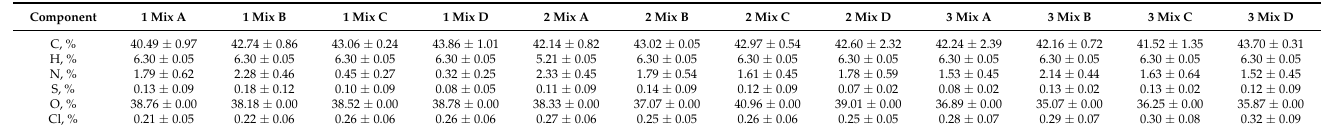
Table 5. Elemental composition properties of pellets.